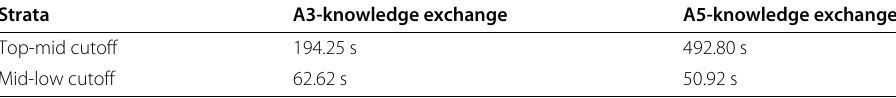
Table 7 Cutoff of three strata of the utterance duration transition graph Strata A3-knowledge exchange A5-knowledge exchange Top-mid cutoff 194.25 s 492.80 s Mid-low cutoff 62.62 s 50.92 s